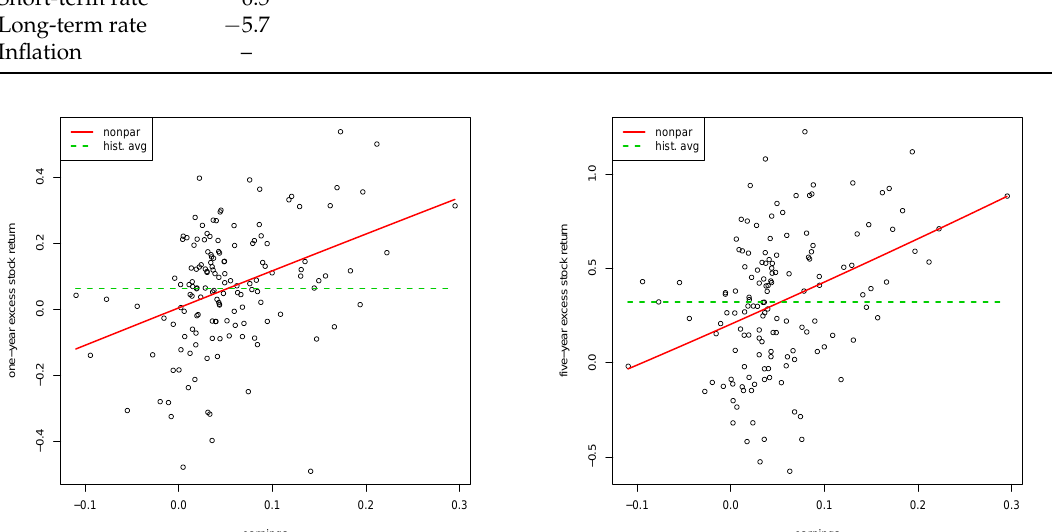
Figure 1. Double inflation benchmark. Relation between real stock returns and real earnings-by-price. Estimated nonparametric function ˆ m (red solid line) and historical average (dashed green line). Left : one-year horizon. Right : five-year horizon. Period: 1872–2019. Data: annual S&P